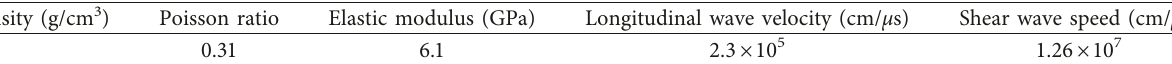
Figure 3: Diagram of experimental test procedure. Table 1: Parameters of